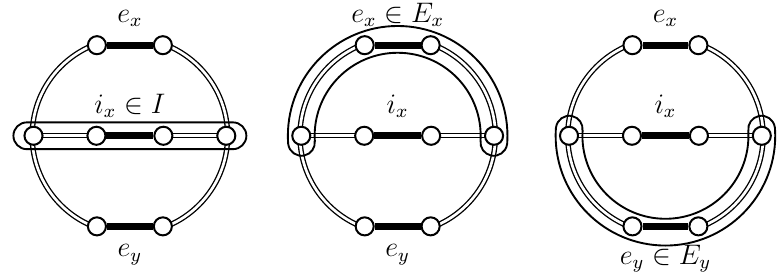
Figure 4. Schematic representation of the relations between E x , E y , and I Figure 4: Schematic representation of the relations between E x , E y and I .